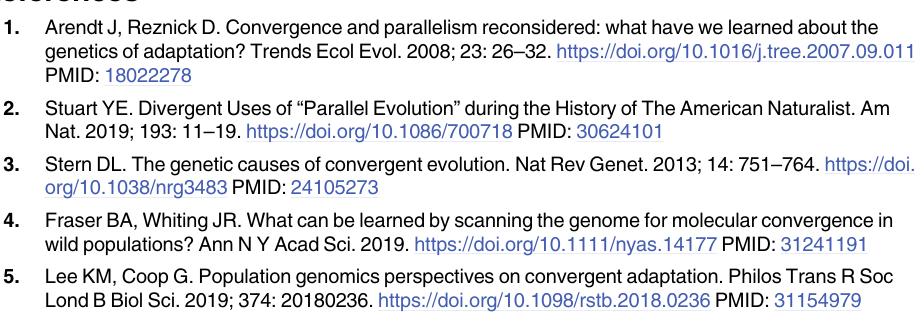
S7 Table. Intersection between BayPass HP/LP association outliers and outliers from selec- tion scans. For each selection scan (final candidate = evidence from > 1 scan), each entry describes the rivers in which that genome window was highlighted as an outlier. S8 Table. Annotated genes in the CL region. Scaffold 000094F_0 is reversed to reflect its placement in chr20. The CL-AP region is highlighted in